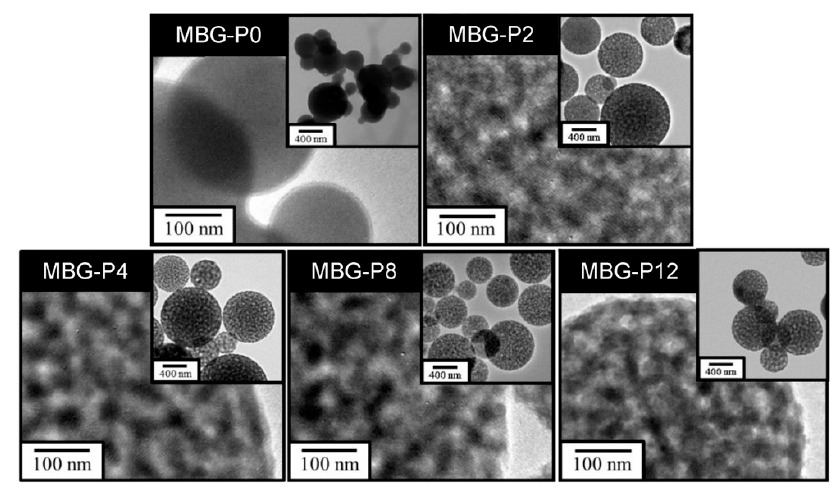
Figure 3. The FE-TEM images of MBG adding different molecular weights of PEG. Table 3. The results of specific surface area and pore size of various MBG powders.